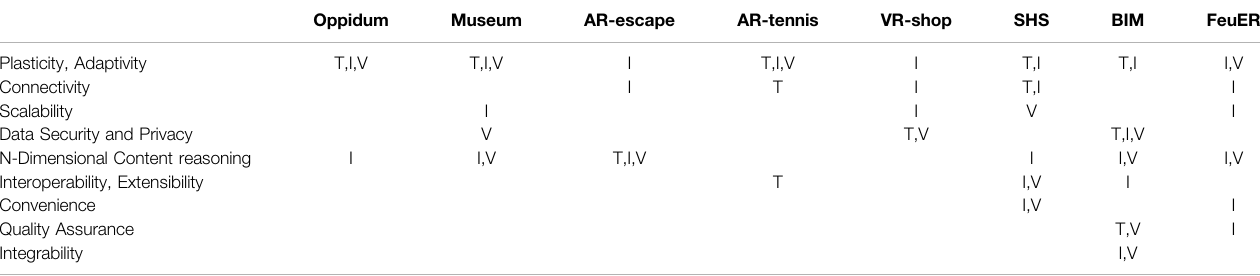
TABLE1| Relationbetweenapplications,requirementsandframeworks.Onlyspecialconsiderationsaremarked,otherwiseabasicneedfor,e.g.,convenienceisassumed. T = UbiTrack, I=Ubi-Interact,